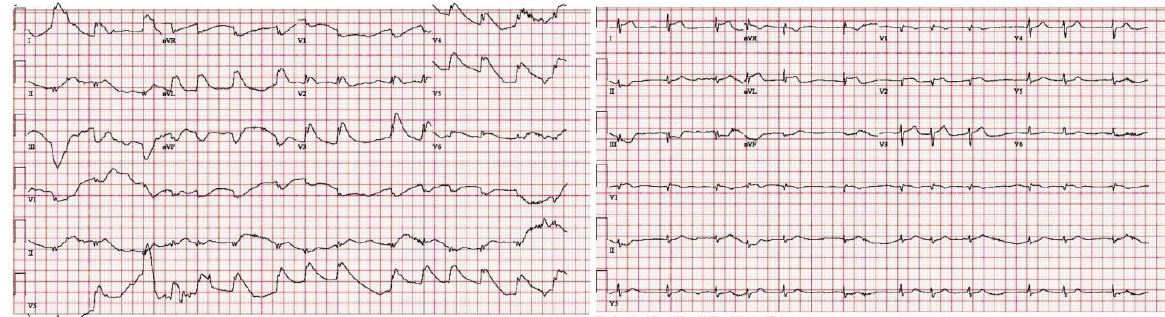
Figure 2. To the left, the electrocardiogram (ECG) immediately following resuscitation. To the right, the ECG approximately 30 minutes after